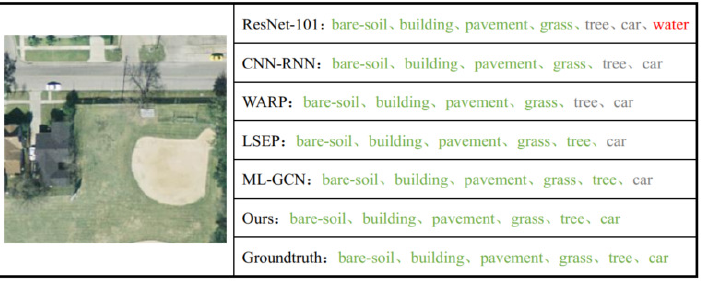
Figure 17. Qualitative results. Example 4.